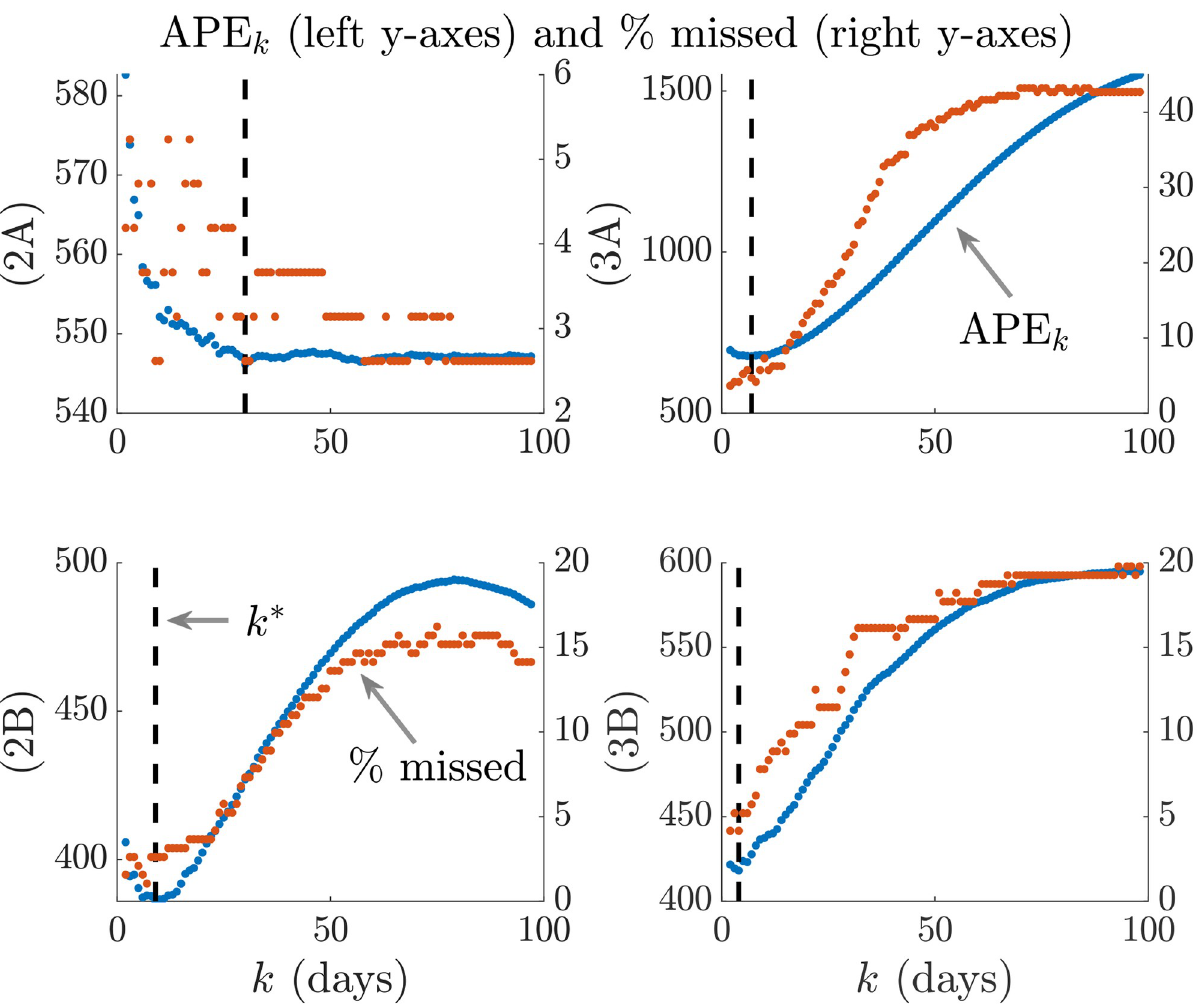
Fig 4. APE prediction accuracy. We compare the APE metric (blue, left y axes) to the percentage of true incidence values, I s +1 that fall outside the 95% (red, right y axes) for various window sizes k . The dashed line is k � . Panels correspond to those of Figs 2 and 3. prediction intervals of x j I s s (cid:0) k þ 1